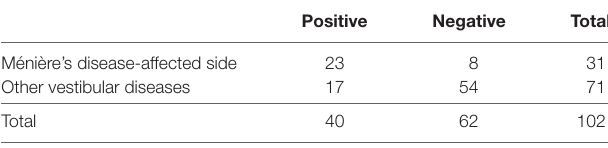
Table 3 | sensitivity and specificity to other vestibular disease patients.